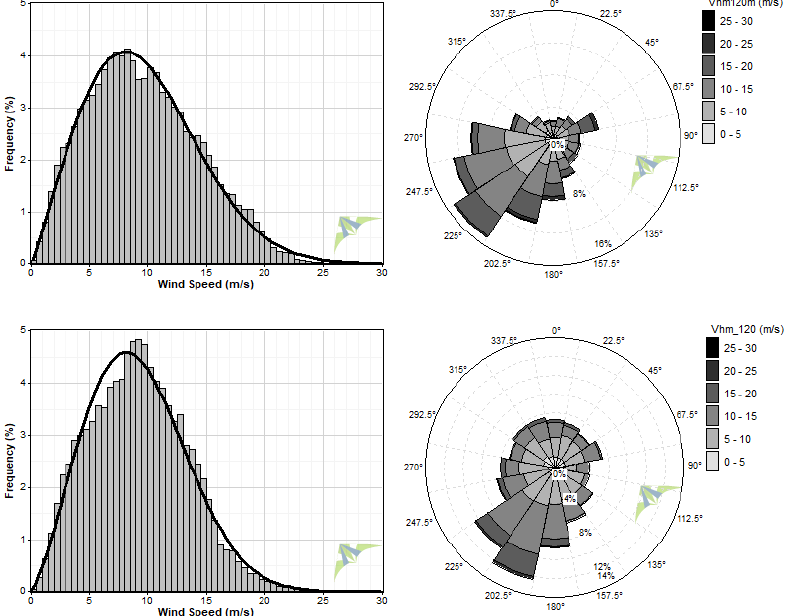
Figure 4. Weibull distribution ( k = 2.12 and A = 10.91ms − 1 ) ( left ) and wind rose ( right ) at Heligoland at 120m for the period 24 March 2017 to 23 March 2018 ( upper panels ), and Weibull distribution ( k = 2.33 and A = 10.39ms − 1 ) ( left ) and wind rose ( right ) at Norderney at 120m for the time period 9 August 2019 to 8 August 2020 ( lower panels